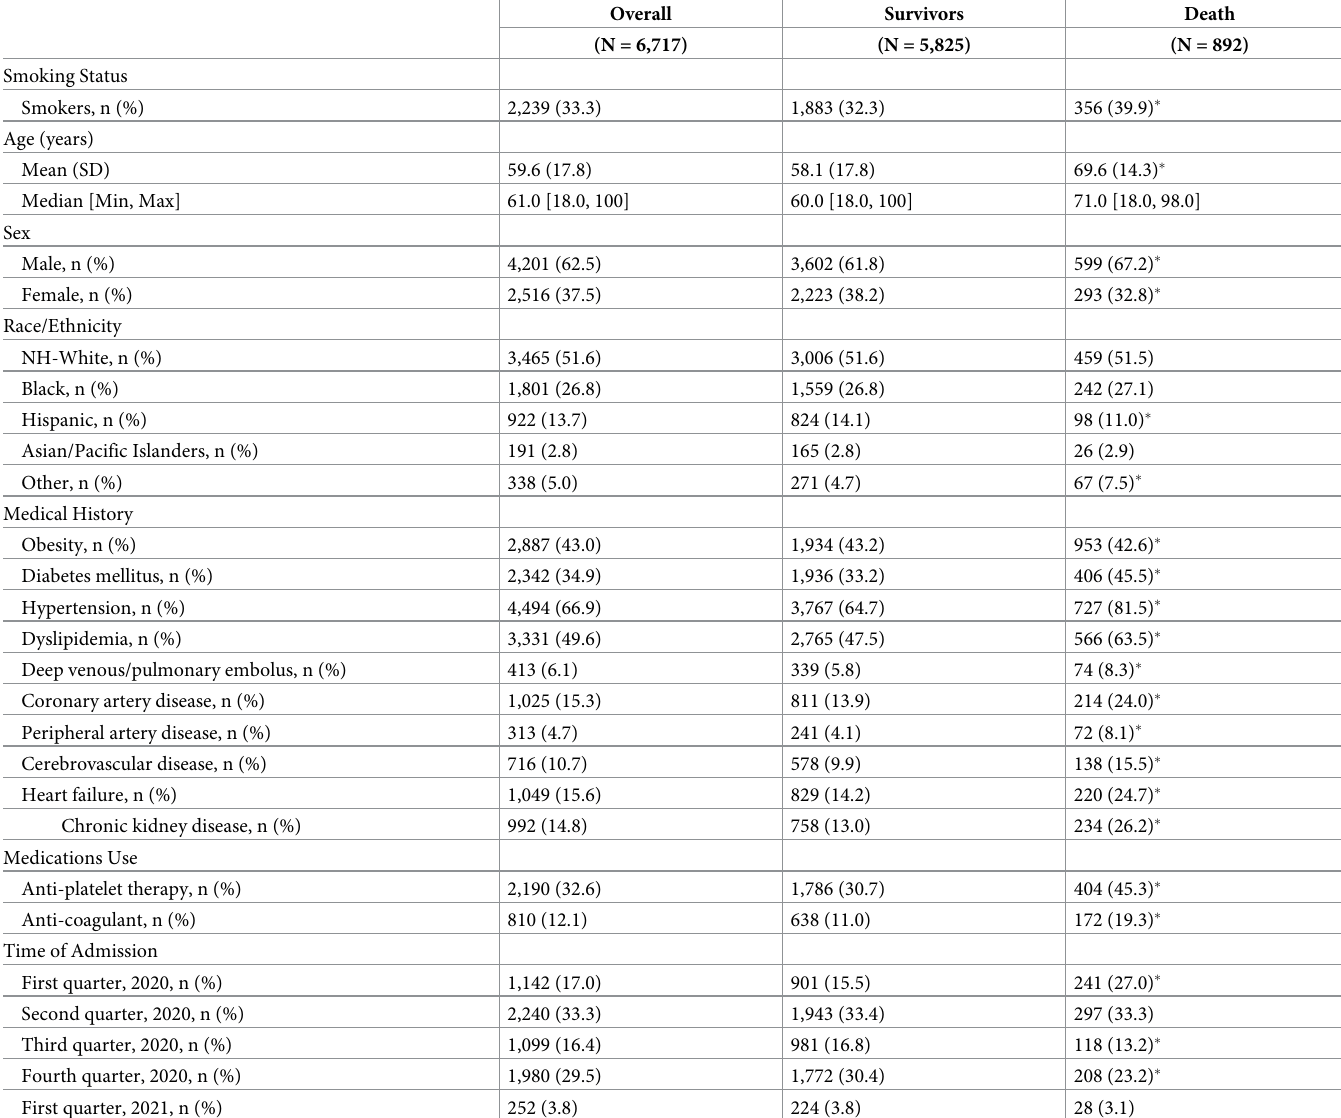
Table 2. Characteristics of the propensity-matched study population of the AHA COVID-19 CVD Registry from December 2020 to March 2021 by survival status.